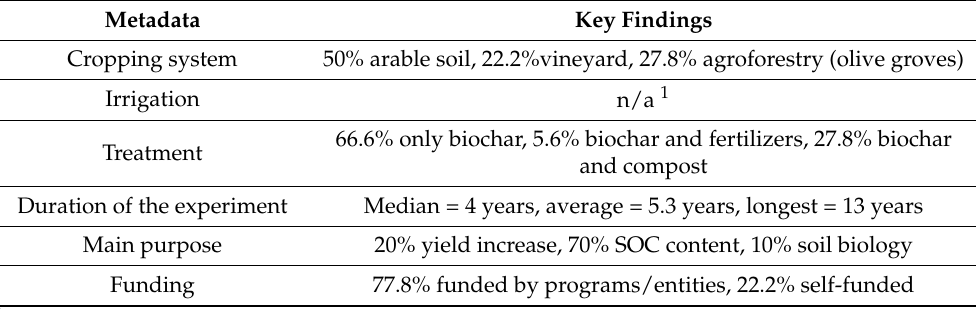
Table 5. Sample of key findings from the LTEP-BIOCHAR